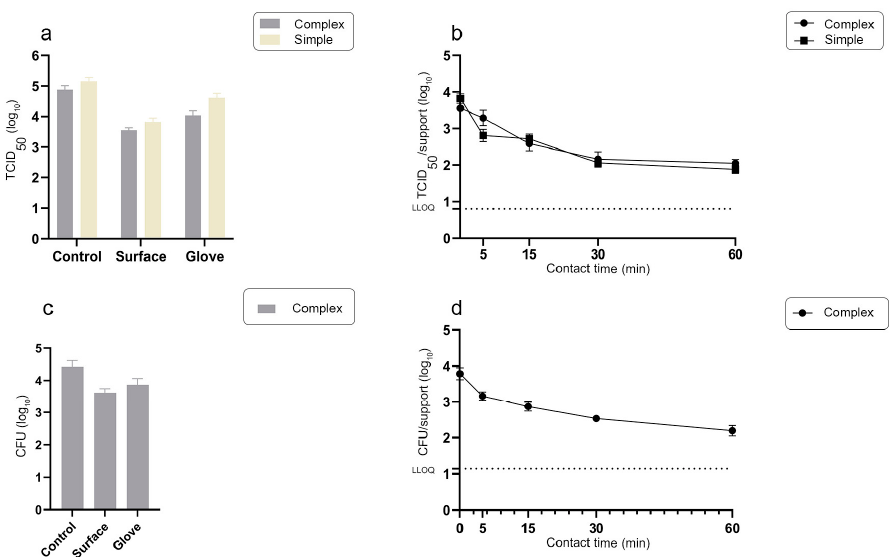
Figure 5. ( a ): Amount of infectious murine norovirus at T0 transferred from the arti fi cially contam- inated gloved fi ngertip to stainless steel supports (REF) and AS03 active surface (surface); residual quantities of virus on gloved fi ngertip after the viral transfer (glove) and from direct washing of fi ngertips prior to transferring to the surfaces (control). Mean values ± SD corresponding to 10 in- dependent viral transfers for each surface. ( b ): Survival of murine norovirus on stainless steel sup- ports (REF) and AS03 active surface after fi nger-pad viral transfer. LLOQ: lower limit of quanti fi ca- tion (LLOQ = 0.8 log 10 TCID 50 ). Mean values ± SD corresponding to 10 inoculated supports for each time point.